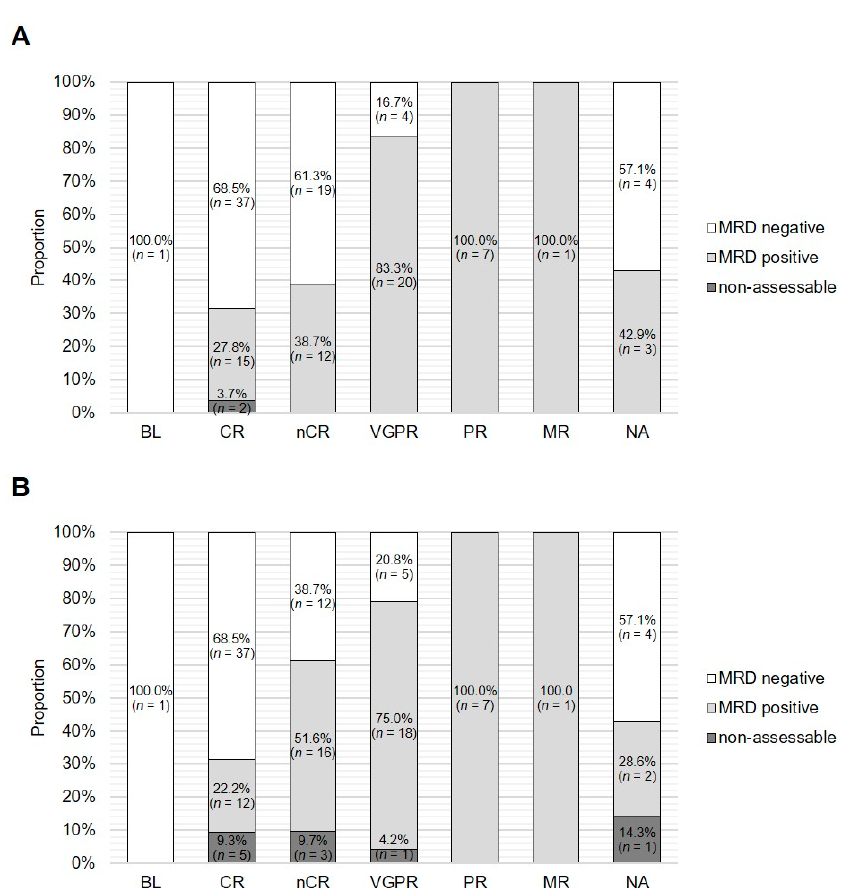
Figure 4. MRD status assessed by NGS and MFC according to serological response. The proportion of MRD-positive, negative and nonassessable cases at the MRD cut-off of 1 × 10 − 5 is shown according to the serological remission status for ( A ) NGS and ( B ) NGF. BL, baseline; CR, complete remission; NA, not available; nCR, near complete remission; PR, partial remission; VGPR, very good partial remission.